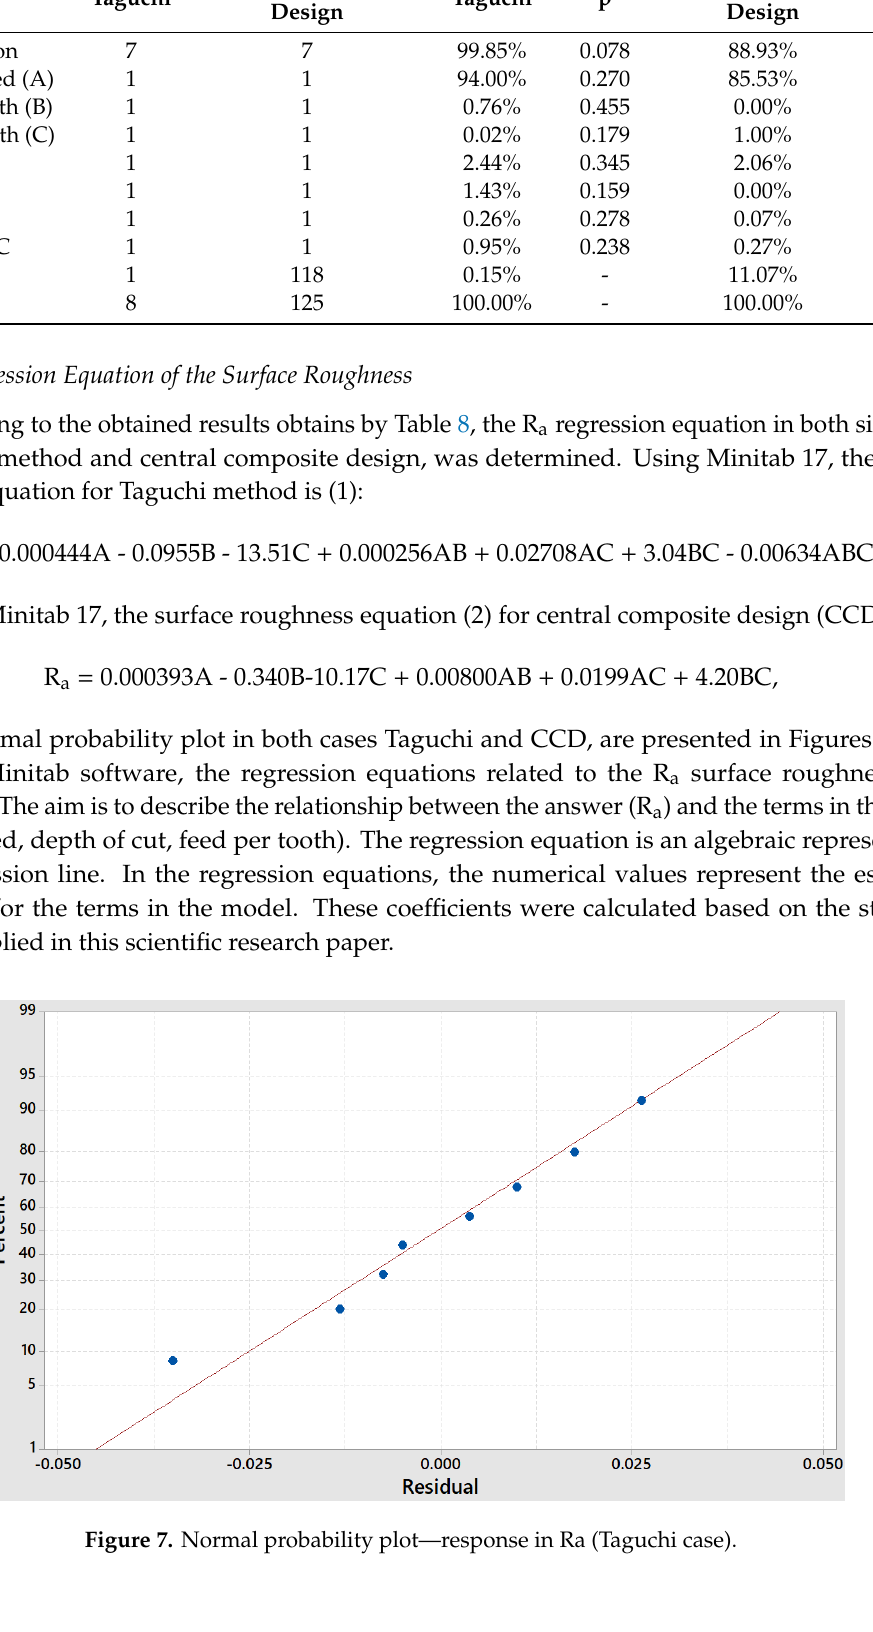
Figure 8. Normal probability plot—response in Ra (central composite design (CCD) case)). 3.3. Comparison Between the Two Regression Equations Determined To make a comparison between the accuracy of these two determined equations using Taguchi′s method and central composite design, Table 10 presents the surface roughness measured values. The surface roughness relative error was calculated between the measure’s values and the calculated values of R a in both situations (Taguchi′s method and central composite design). Table 10. The relative errors between the measured and the calculated surface roughness values [22, pp.178].